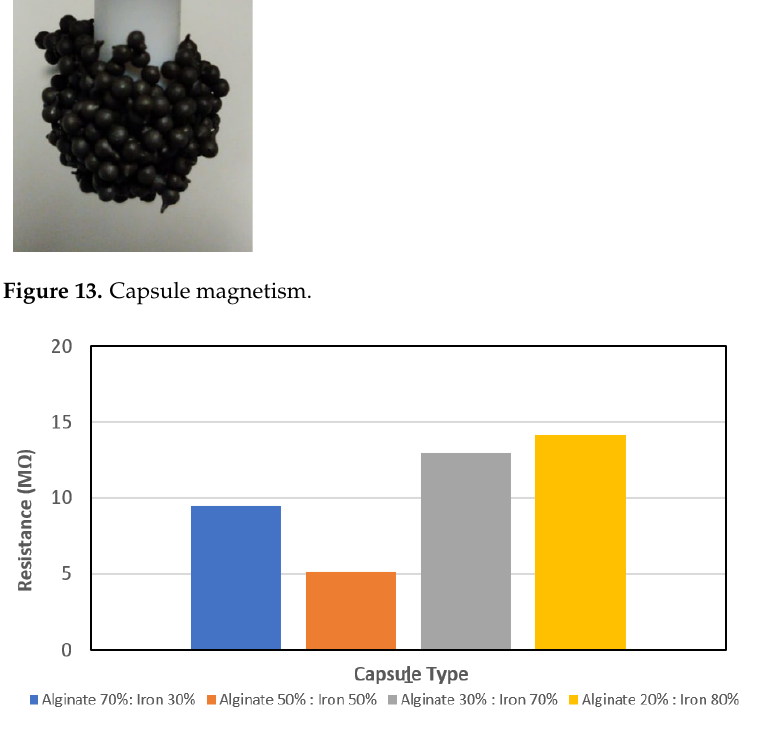
Figure 14. Capsule resistance.